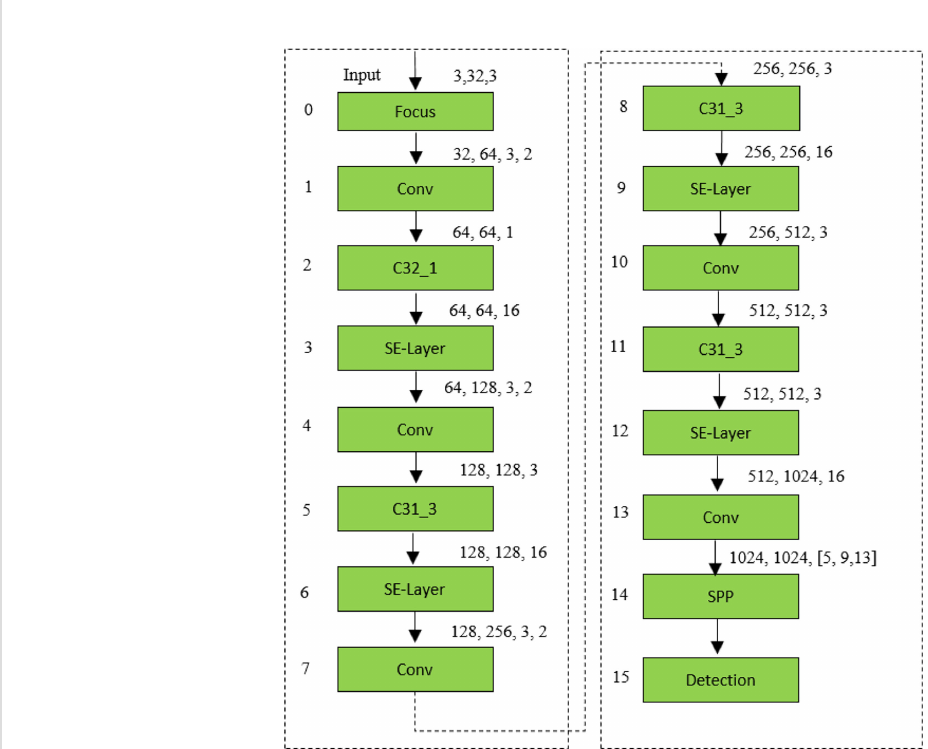
FIGURE 5 The improved backbone Network